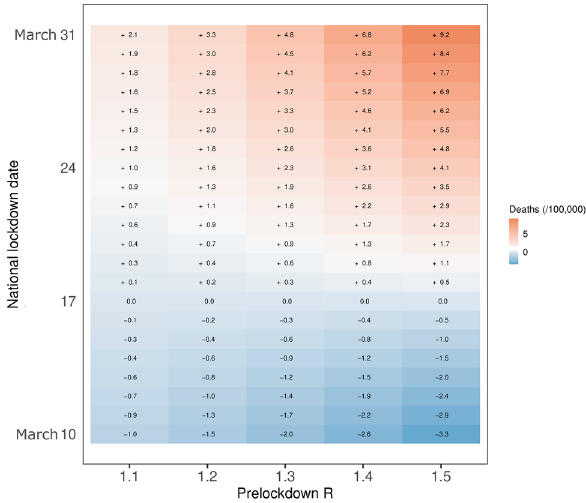
Figure 4. Change in the number of deaths per 100,000 inhabitants for metropolitan France according to lockdown date and value of the pre-lockdown reproduction number compared to the observed national lockdown in the hypothesis of a slower epidemic